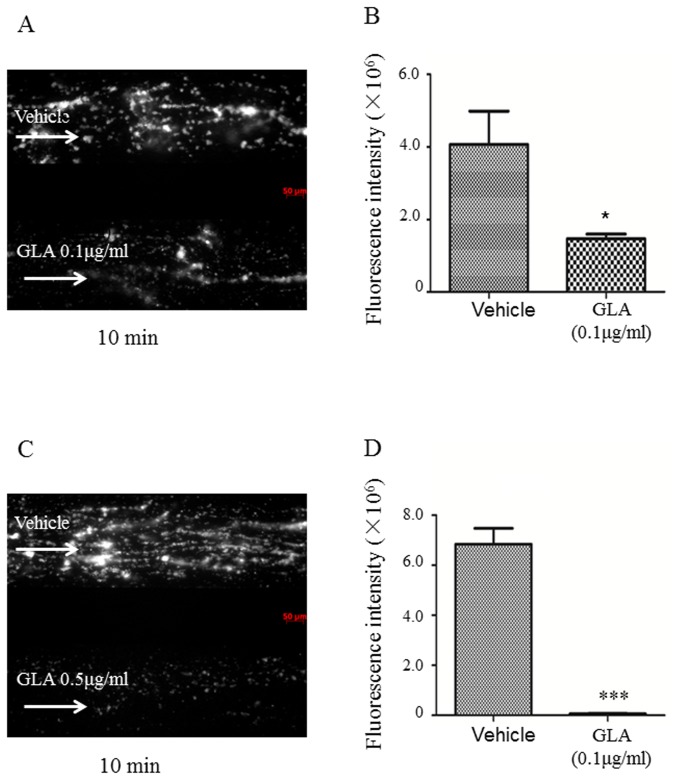
Effects of GLA on platelet adhesion on collagen-coated surfaces.
Human whole blood was labeled with Calcein-AM, treated with (lower channels) or without (upper channels) 0.1μg/ml (A) or 0.5μg/ml (B) of GLA, and perfused over collagen-coated surface for 30 min at a shear rate of 40 dyn/cm2 (1000s-1). Platelet adhesion and aggregates were observed under a fluorescence microscope. Photos were taken at 10min (A) after flow. Arrow indicates the flow direction. Data plotted are means ± standard errors of fluorescence intensity of three individual experiments (*P < 0.05, ***P < 0.01). The Student t test was used to calculate P values for differences.